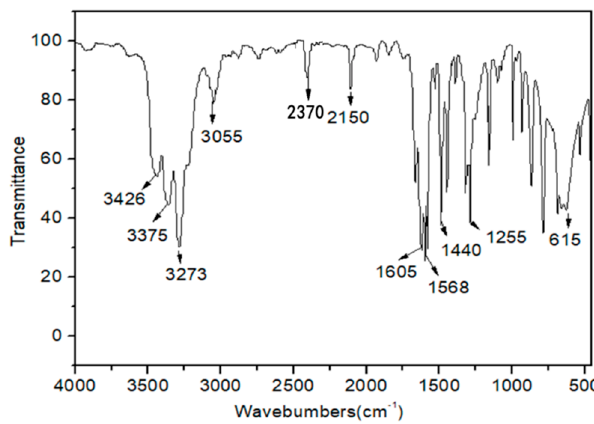
Figure 2. The FTIR spectrum of ZAA.